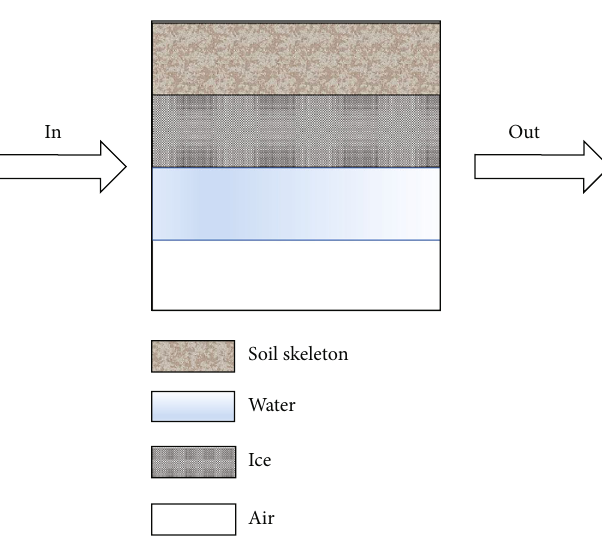
Figure 6: Simpli fi ed parallel (horizontal)